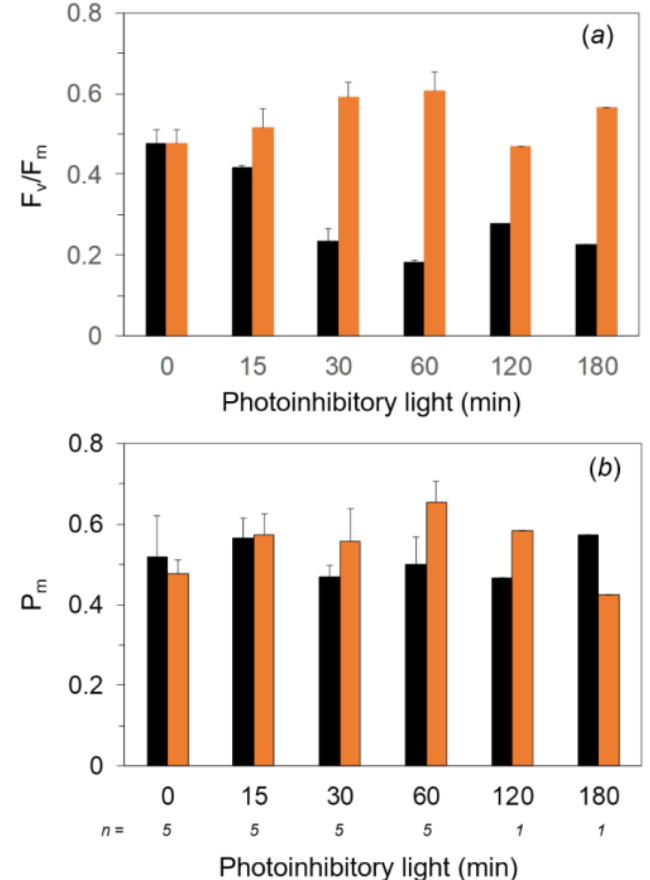
Figure 2. F v /F m ( a ) and P m ( b ) after the exposure to strong light and the subsequent moderate light at low temperatures in the filamentous cells dissected from the spherical marimo. Dark-treated filamentous cells were exposed to the white light at 800 µ mol m − 2 s − 1 for up to 180 min at 2 ◦ C on ice. After the high light for each given time, the filamentous cells were dark-treated for 30 min, and F v /F m and P m were measured at 4 ◦ C (black bar). The photoinhibited filamentous cells at each illuminating time were irradiated by the white light at 250 µ mol m − 2 s − 1 used as the repair light for 30 min at 2 ◦ C on ice, and then F v /F m and P m were measured at 4 ◦ C after the dark treatment for 30 min (orange bar). Measurements were taken in the cold room (40 Pa CO 2 , 21 kPa O 2 , at 4 ◦ C). The values represent the means ± SD ( n = 1–5). The redox states of PSI showed no significant differences by PSII photoinhibition: Y(I) was decreased with the PPFD levels, Y(ND) was increased with the PPFD levels, and Y(NA) reached the maximum at a moderate PPFD of 250 µ mol m − 2 s − 1 (Figure 3a,c,e). Y(II) in the inhibited cells was markedly reduced at low to moderate PPFDs up to 250 µ mol m − 2 s − 1 . Y(II) in the repaired cells was similar to that in the intact cells (Figure 3b). The inhibited cells showed the largely depressed Y(NPQ) (Figure 3d) and slightly higher qL than the intact and repaired cells at PPFDs above 250 µ mol m − 2 s − 1 (Figure